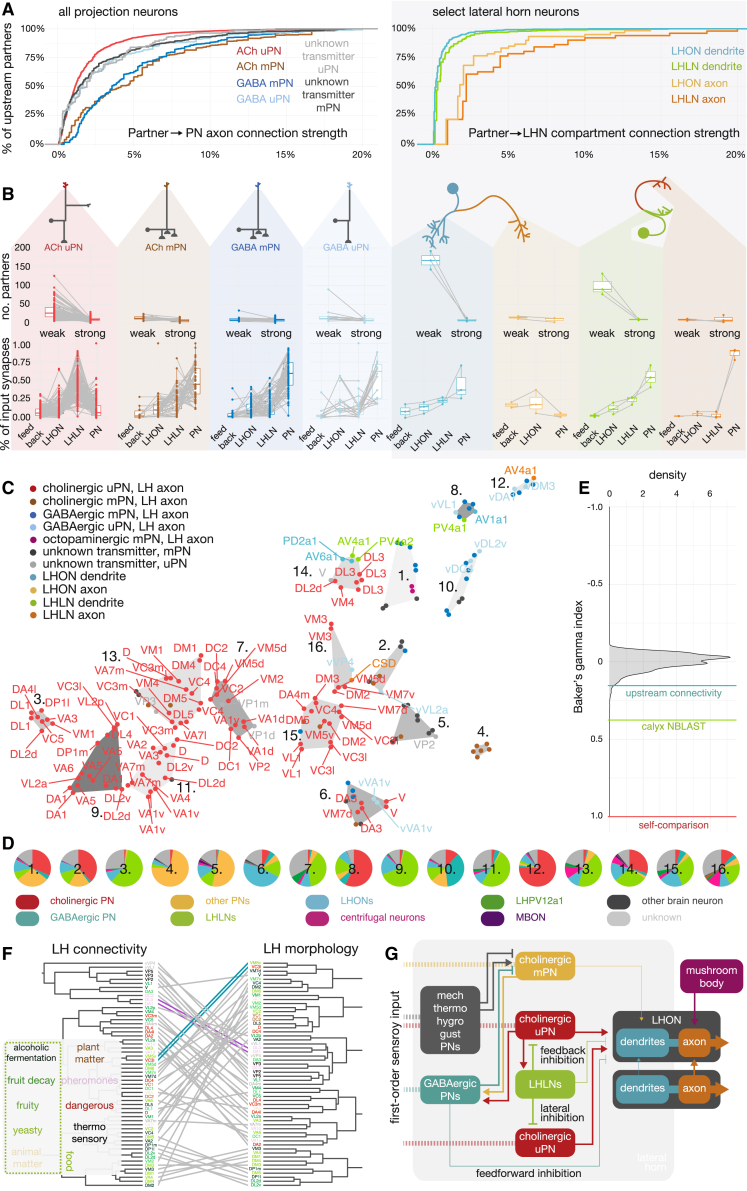
Upstream Connectivity of PNs in the LH and for Select LH Neurons(A) Left, empirical cumulative density plots for the unitary connection strengths of all upstream partners to downstream PN axons and 6 exemplary LHNs.(B) Top, number of weak (<1% of target’s synapses accounted for by an upstream partner) and strong (≥1%) synaptic partners. Bottom, proportion of neurons’ total inputs coming from feedback neurons, LHONs, LHLNs, and olfactory PNs, where “feedback” refers to input from MBONs and LH centrifugal neurons. Split by class and compartment (colored facets).(C) A t-SNE plot based on synaptic budget vectors for each target neuron, where each value in the vector is the normalized number of synapses supplied by a different upstream neuron class. Grey polygons correspond to a K-means clustering, k = 16.(D) Pie charts show how the input budget of selected clusters in (C) is spent.(E) Density plot of hierarchical clustering similarity scores (Baker’s gamma index, [47, 48]) between a hierarchical clustering of NBLAST scores [49] for PN axons in the LH and 10,000 random permutations of this clustering (red line, self-comparison). Baker’s gamma index between this morphological clustering and an upstream connectivity clustering shown in blue (0.21, one-sided p value < 0.005), and a comparison with a NBLAST cluster of calycal terminals in green (0.24, one-sided p value < 0.005). To calculate this similarity index, the maximum number of clusters for which each pair of neurons falls into the same grouping is computed. A Spearman correlation is then calculated between two sets of these numbers, one for each hierarchical clustering.(F) Tanglegram comparing hierarchical clustering based on upstream connectivity similarity (cosine similarity between vectors for synaptic connectivity) and morphological similarity (NBLAST). Label colors indicate the coarse odor scene in which uPNs are likely to respond [42]. If a PN falls into more than one odor scene, only one color is chosen. Colored lines indicate groups of neurons clustered together in both dendrograms.(G) Schematic of the connectivity motifs found in the LH.See also Figure S5; Data S1 and S4.